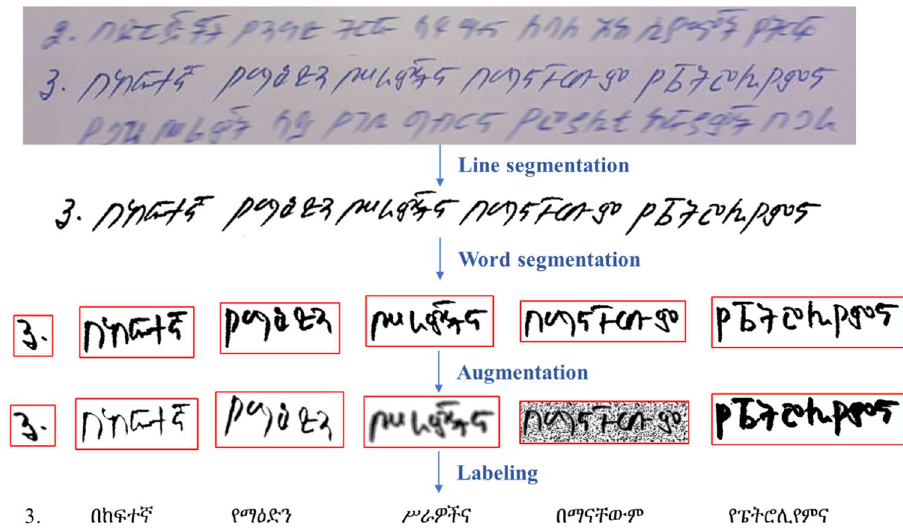
Fig. 3 An example of data pre-processing and augmenta- tion techniques used during handwritten Amharic word dataset preparation